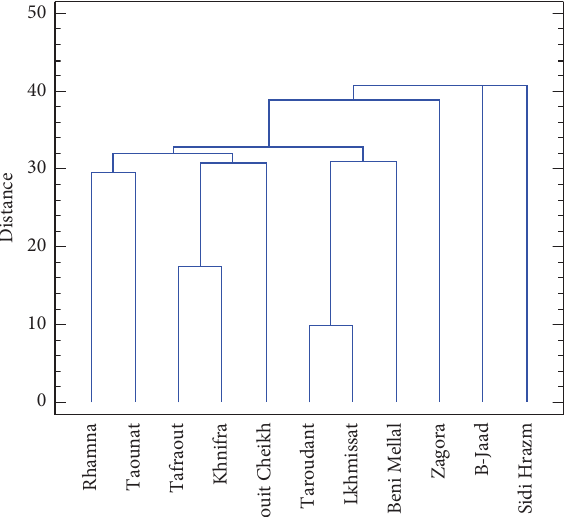
Figure 3: Cluster analysis performed on mean values in the Z . lotus fruit samples collected from eleven Moroccan origins. Distance ( Y axis) is the Euclidean distance among fruit samples based on the investigated fruit traits.